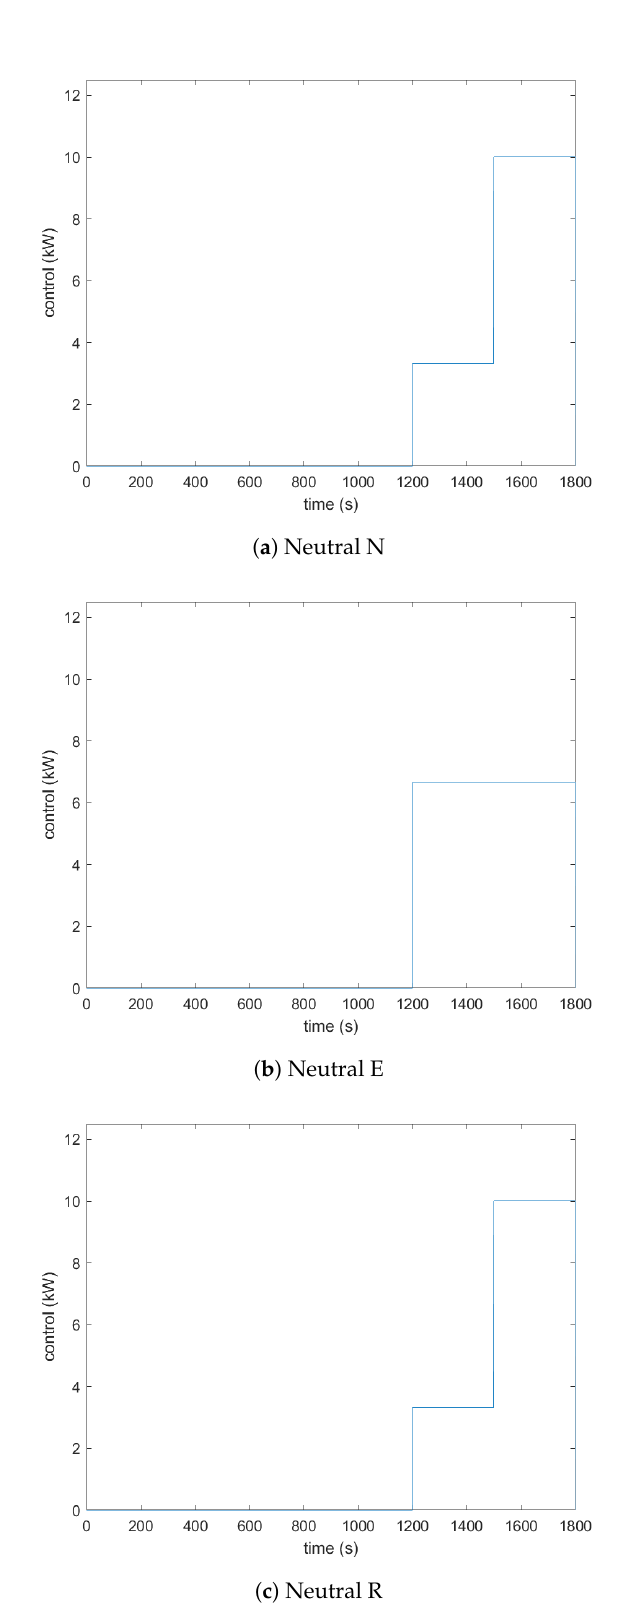
Figure 15. The optimal battery heating strategies generated according to the 3 weightings designed to produce a neutral balance between the battery and cabin at − 7 ◦